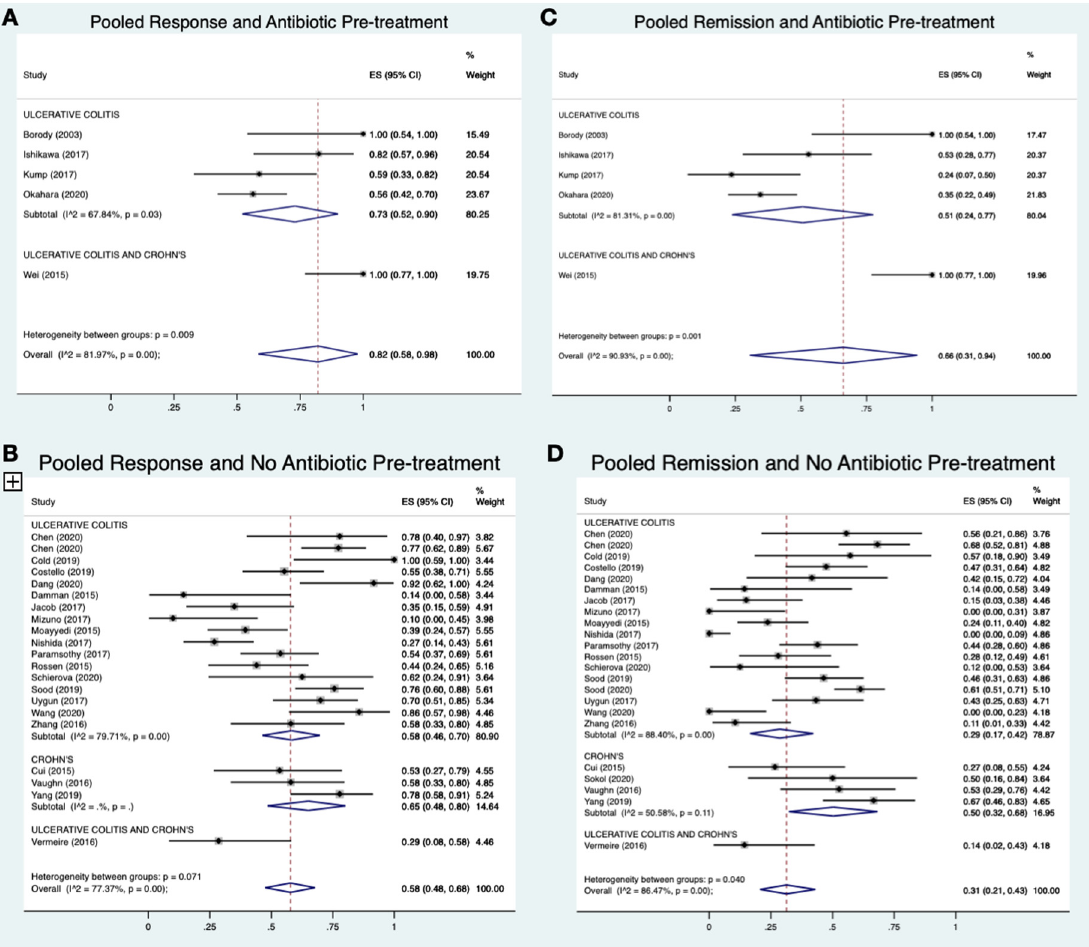
Figure 3. A-3D : Meta-analysis of pooled response and remission rate for antibiotic pre-treatment vs. no pre-treatment.